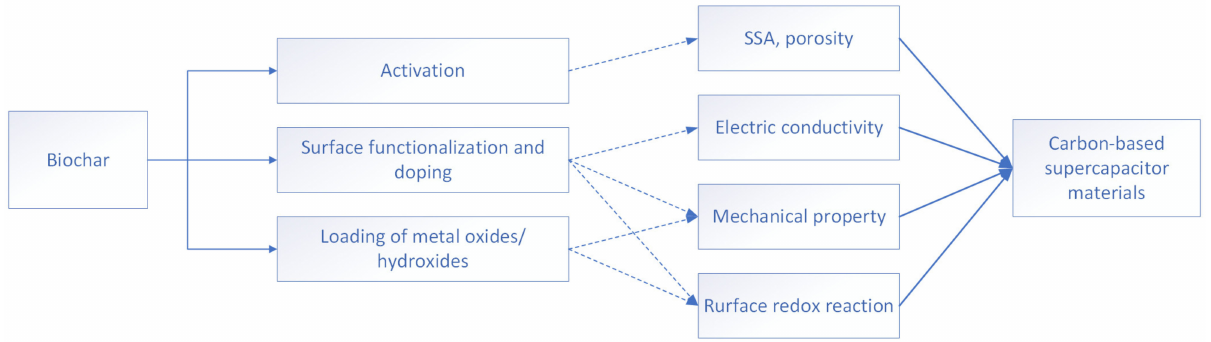
Figure 5. High-rate performance activated carbons prepared from ginkgo shells for electrochemical